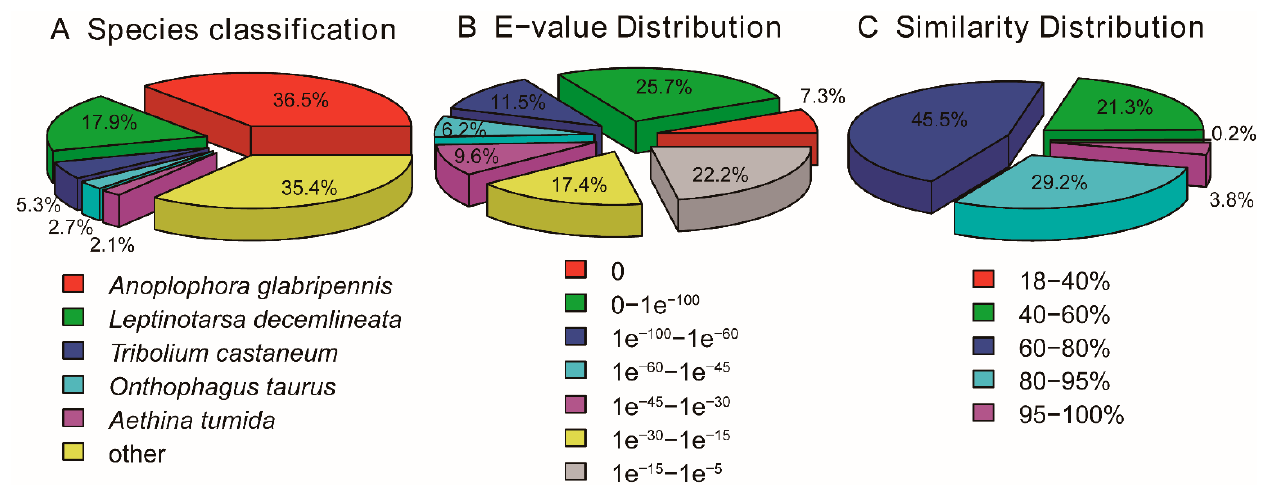
Figure 1. Pie charts showing distribution of the BLASTxmatches of Donacia provosti transcriptome unigenes against the NR database. ( A ) Species classification, ( B ) E-values distribution, and ( C ) Similarity distribution.